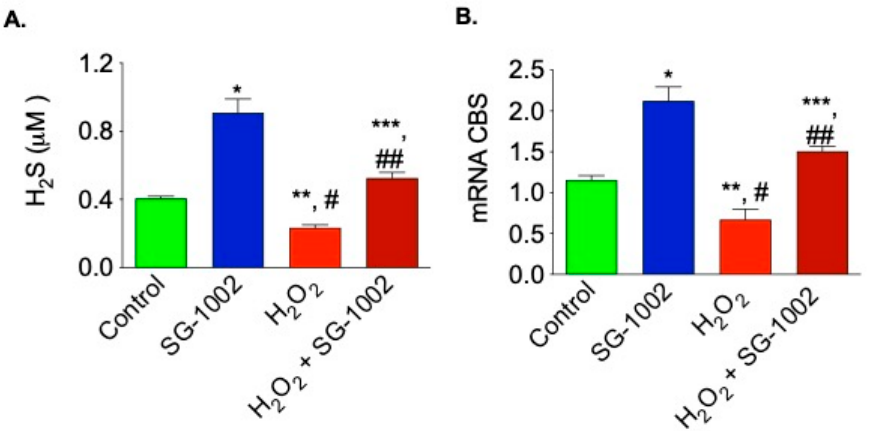
Figure 5. Effects of SG-1002 on H 2 S production and CBS mRNA expression when cells were cultured under stress. HL-1 cells were incubated with specific reagents as described in Materials and Methods for 1 h in 1% serum containing media followed by the measurement of H 2 S levels in culture media ( A ) and analysis of CBS mRNA ( B ) using the TaqMan PCR assay system. *, and **, p < 0.05 vs. control; #, p < 0.05 SG-1002 vs. H 2 O 2 ; ##, p < 0.05 H 2 O 2 vs. SG-1002 + H 2 O 2 ; ***, p < 0.05 SG-1002 vs. SG 1002 + H 2 O 2 (Anova) (n = 3).